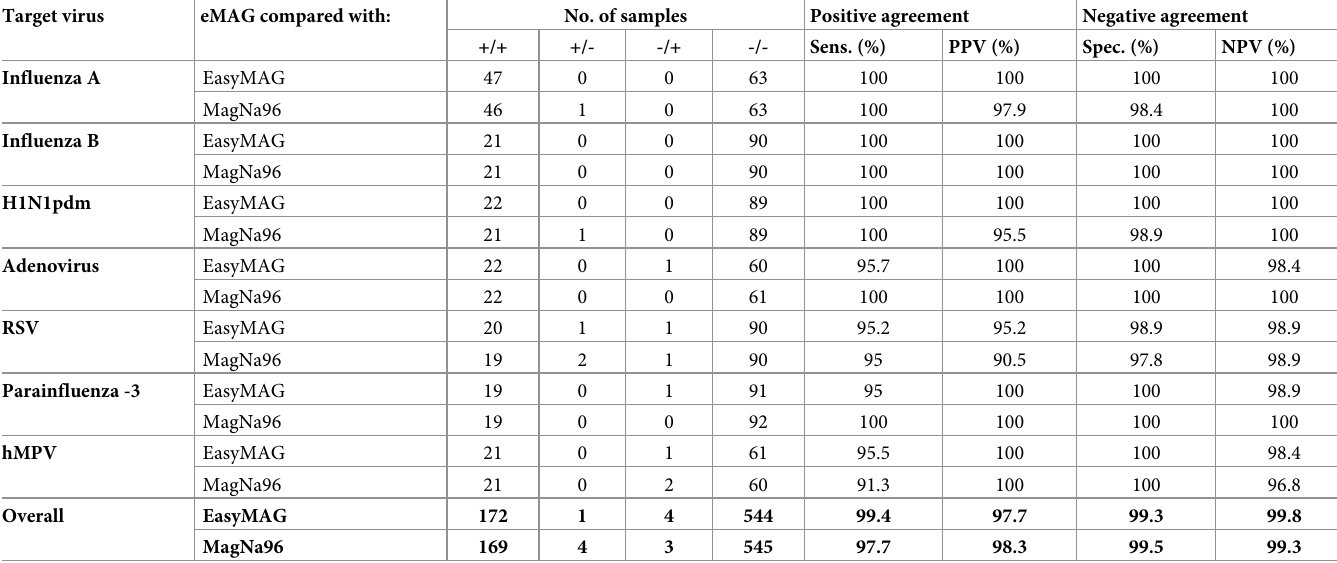
Table 2. Comparison of eMAG with EasyMAG or MagNa96. Target virus eMAG compared